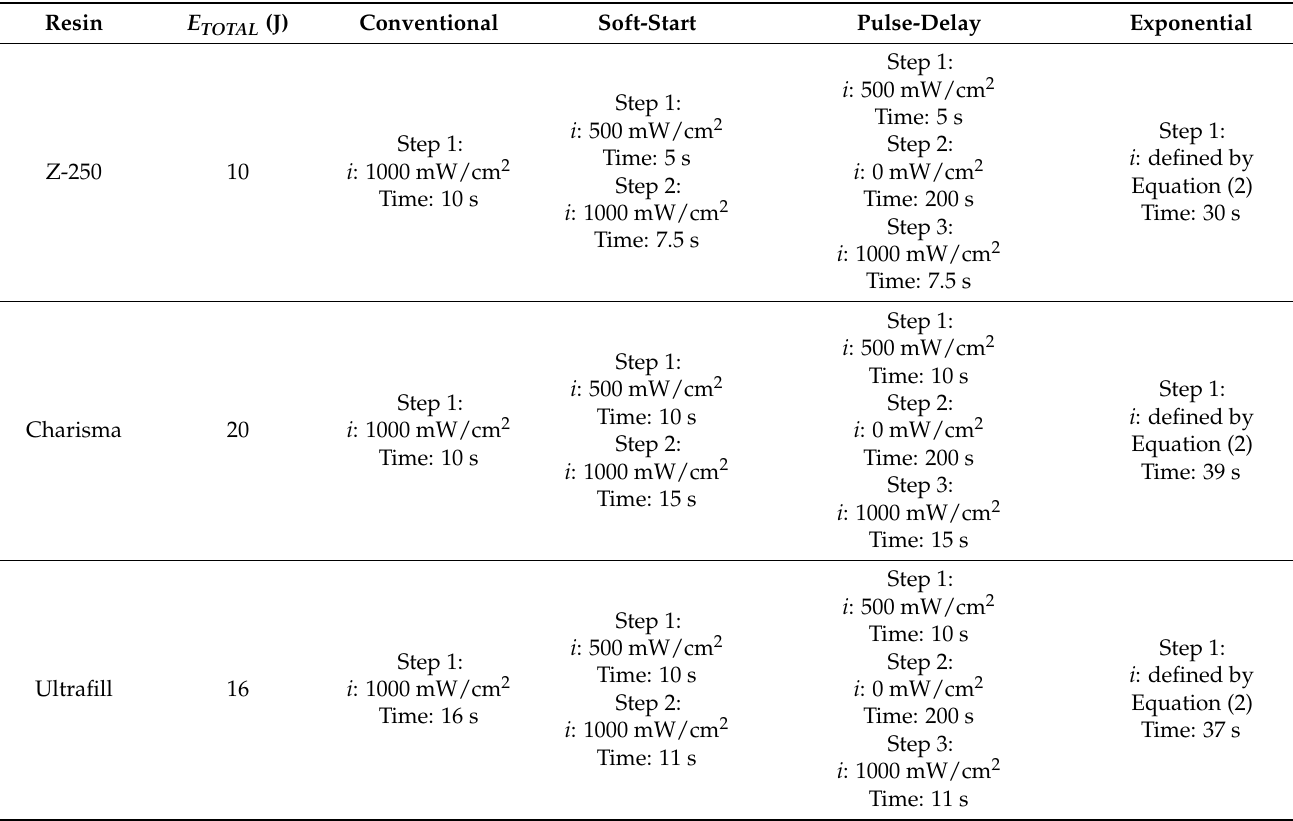
Table 2. Photoactivation parameters for all techniques/resins in our study. The variable i corresponds to irradiance. Resin E TOTAL (J) Conventional